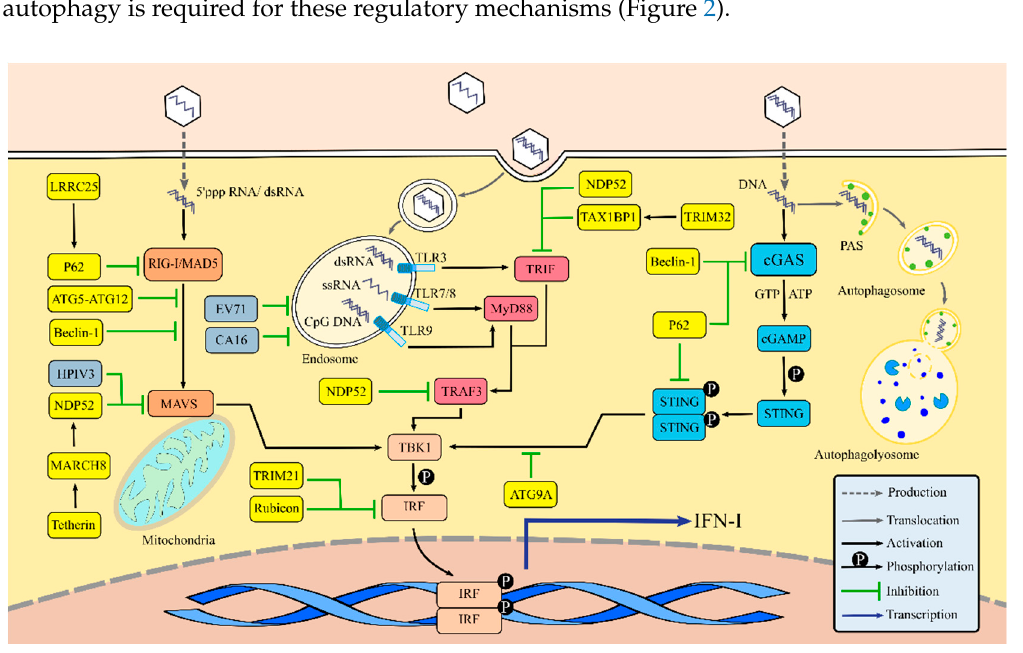
Figure 2. Autophagy regulates the expression of IFN-I. There are three major pattern recognition receptor (PRR) signaling pathways for regulating IFN-I expression, including the RLRs, TLRs, and cGAS-STING pathways. After recognizing a viral pathogen-associated molecular pattern (PAMP), PRRs recruit downstream signaling molecules, activate signaling cascades via TBK1 and IRF, and ultimately result in the expression of IFN-I. Autophagy can regulate virus detection by degrading viral PAMPs or delivering viral PAMPs to endosomes. Autophagy-related gene (ATG) proteins such as ATG5, ATG9A, ATG12, and Beclin-1 function as regulators of IFN-I production. Selective autophagy mediated by P62, NDP52, and TAX1BP1 plays a vital role in balancing the PRR-mediated IFN-I signaling. Viruses such as HPIV3, EV71, and CA16 can also manipulate key molecules of the autophagic process to inhibit IFN-I production.